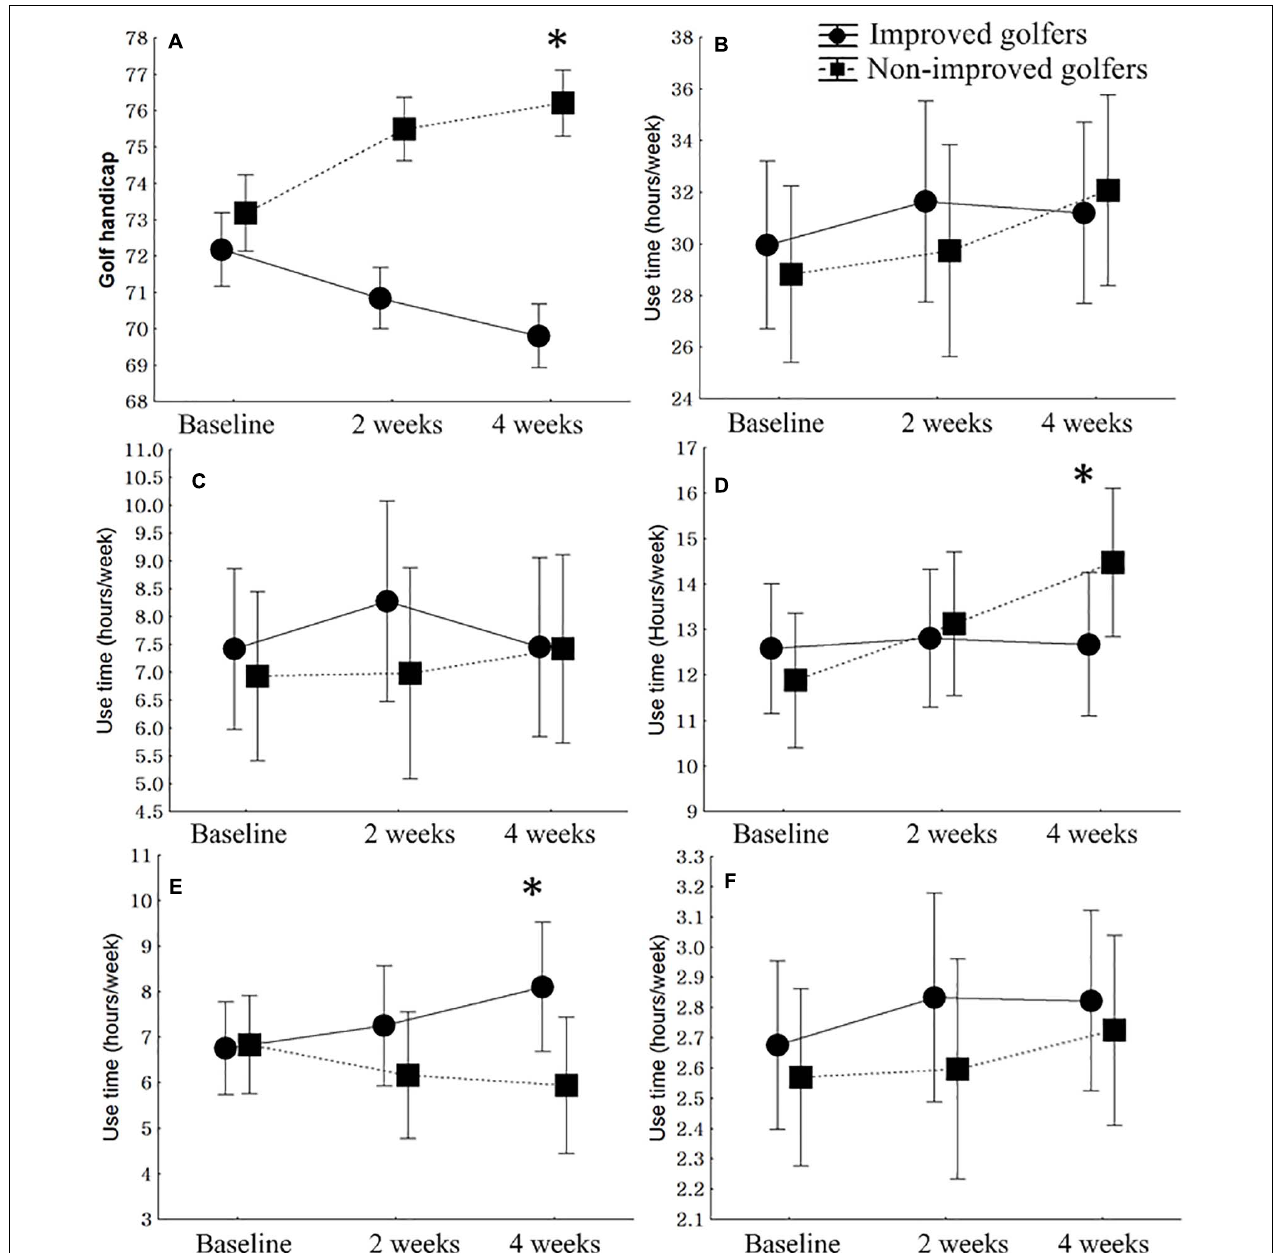
FIGURE 1 | Comparison of changes in modified golf scores and smartphone use time of improved and non-improved golfers. (A) Golf handicap, F = 57.76, p < 0.01, η 2 = 0.4513. (B) Total smartphone use time, F = 2.84, p = 0.09, η 2 = 0.123. (C) Social network service, F = 2.69, p = 0.08, η 2 = 0.262. (D) Entertainment apps (media applications including listening to music and watching movies and dramas, webtoons, games), F = 5.03, p = 0.01, 2 η = 0.308. (E) Serious apps (internet browsers, books and reference apps, camera, swing analysis apps, schedule apps, education), F = 5.25, p < 0.01, η 2 = 0.353. (F) Other apps (shopping, delivery service, etc.), F = 1.11, p = 0.30, η 2 =